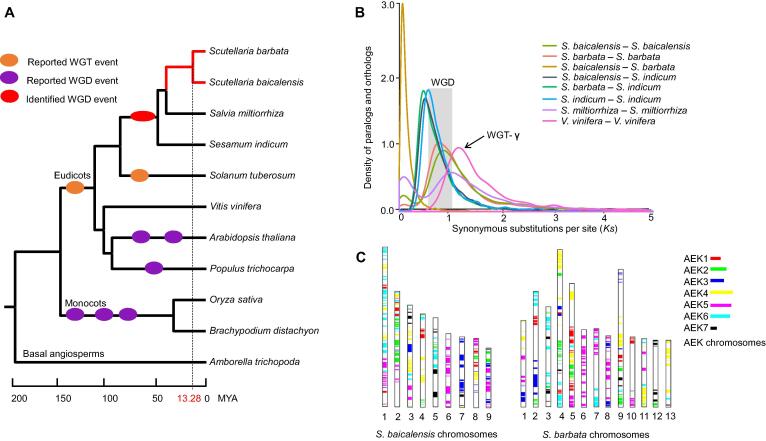
Shared WGD events of Lamiaceae and PedaliaceaeA. The phylogenetic tree based on the concatenated method using 235 single-copy orthologous genes from 11 angiosperms was constructed. The basal angiosperm Amborella trichopoda was chosen as the outgroup. The red branches represent two Scutellaria species, S. baicalensis and S. barbata. Speciation time was estimated based on the reported divergence time for A. trichopoda–Vitis vinifera (173–199 MYA) and Populus trichocarpa–Arabidopsis thaliana (98–117 MYA). The dashed line represents the divergence time between S. baicalensis and S. barbata. The orange ovals represent the reported WGT events. The purple and red ovals represent the reported WGD events and the newly identified WGD event in this study, respectively. The reported WGT/WGD events represent the WGT/WGD events identified in previous studies, including the WGT–γ event in core eudicots, WGT event in Solabun tuberosum, and WGD events in Sesamum indicum, A. thaliana, P. trichocarpa, Oryze sativa, and Brachypodium distachyon. B. Synonymous substitution rate (Ks) distributions of syntenic blocks for the paralogs and orthologs of S. baicalensis, S. barbata, S. miltiorrhiza, S. indicum, and V. vinifera. The gray box indicates the shared WGD event in S. baicalensis, S. barbata, S. miltiorrhiza, and S. indicum.C. Comparison with AEK chromosomes. The syntenic AEK blocks are painted onto S. baicalensis and S. barbata chromosomes separately. MYA, million years ago; WGT, whole-genome triplication; WGD, whole-genome duplication; AEK, ancestral eudicot karyotype.